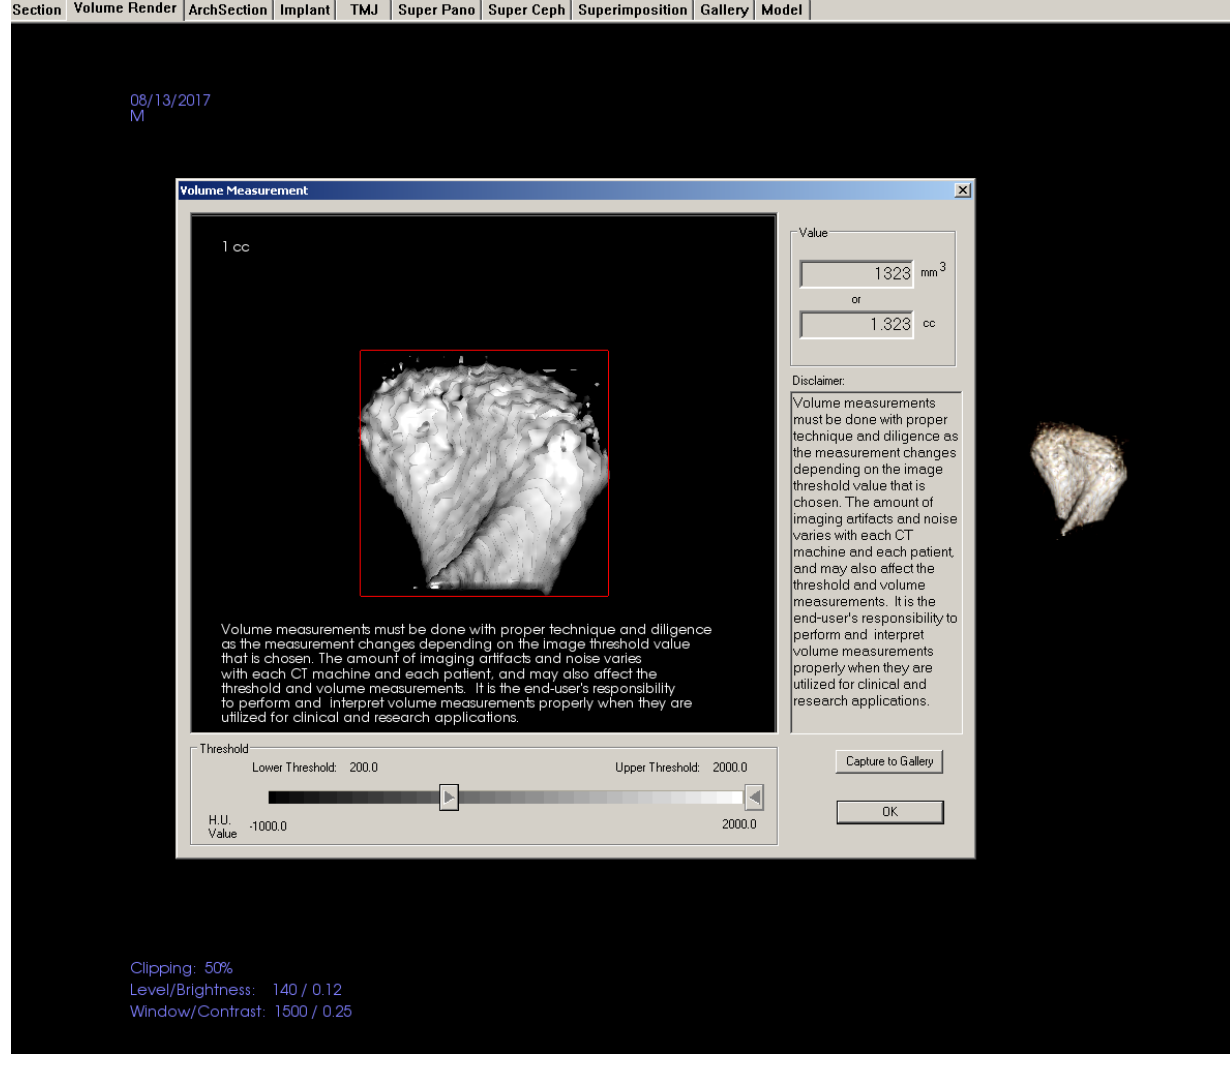
Figure 8. Condylar volume measurement.